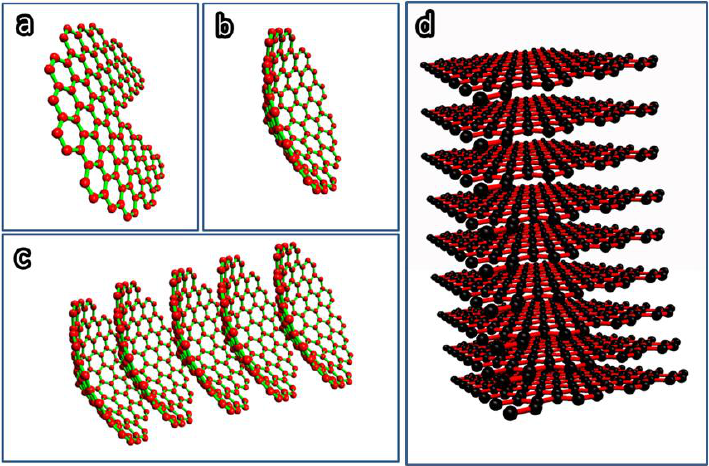
Figure 2. Schematic demonstration of ( a – c ) formation of cup-stacked CNF structure; and ( d ) platelet CNF structure.